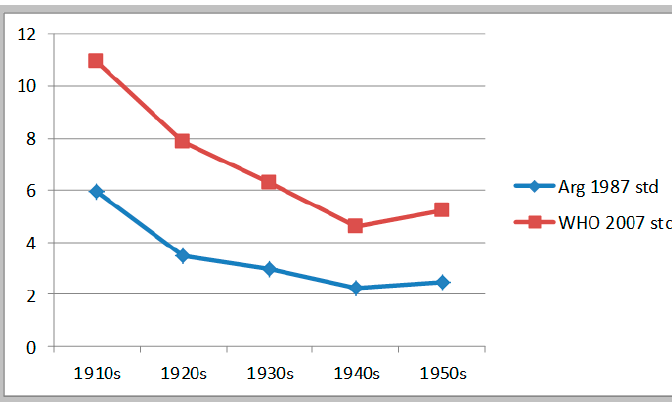
Figure 5. Evolution of moderate & severe stunting. Recruits from Pampa Region b.1916–1951.